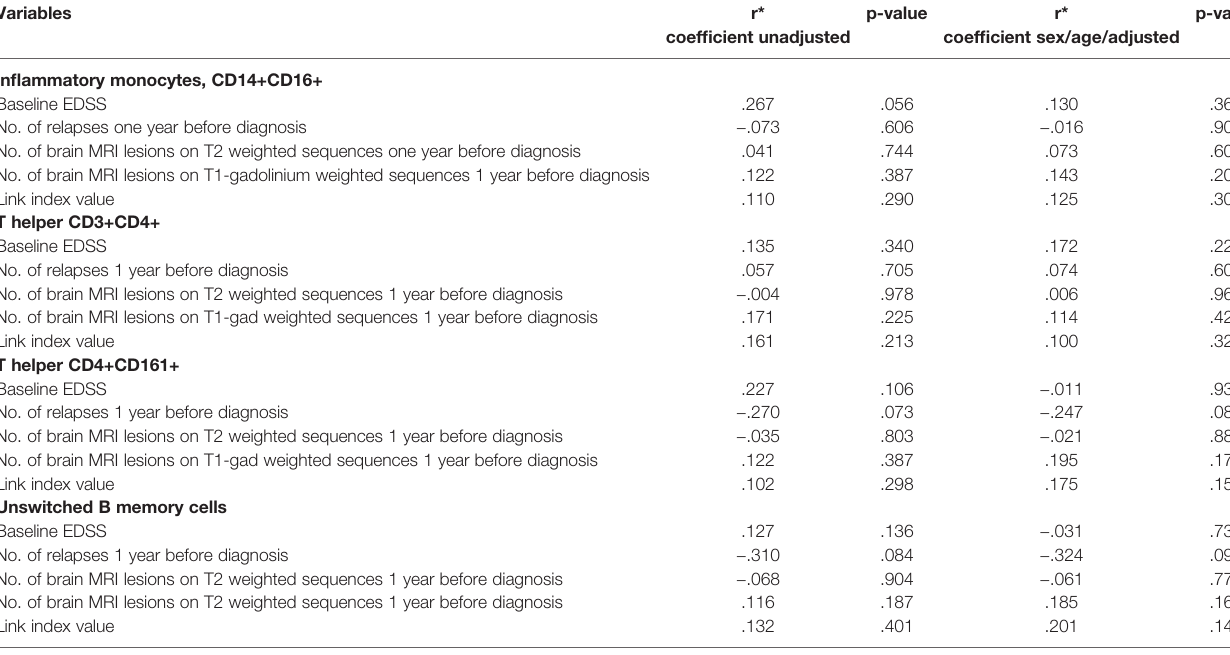
TABLE 2 | Correlation analyses between cell subsets and clinical/radiological parameters at disease onset. Variables r* p-value r* p-value coef fi cient unadjusted coef fi cient